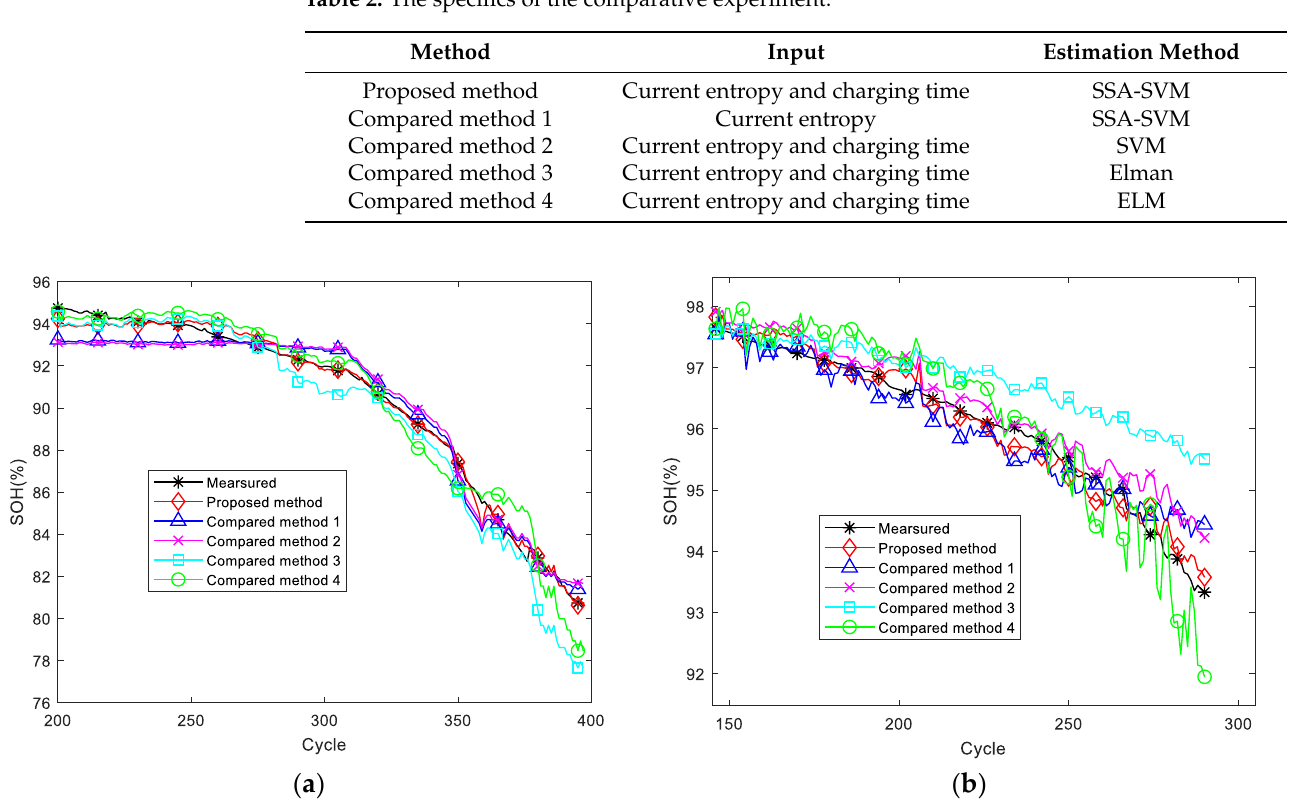
Figure 9. The comparison results of comparative experiment. ( a ) Battery pack; ( b ) battery cell. The absolute error between the battery SOH estimation values and the measurement SOH values are shown in Figure 10. The mean absolute error (MAE), maximal error (ME) and computational burden of the comparative experiment are displayed in Table